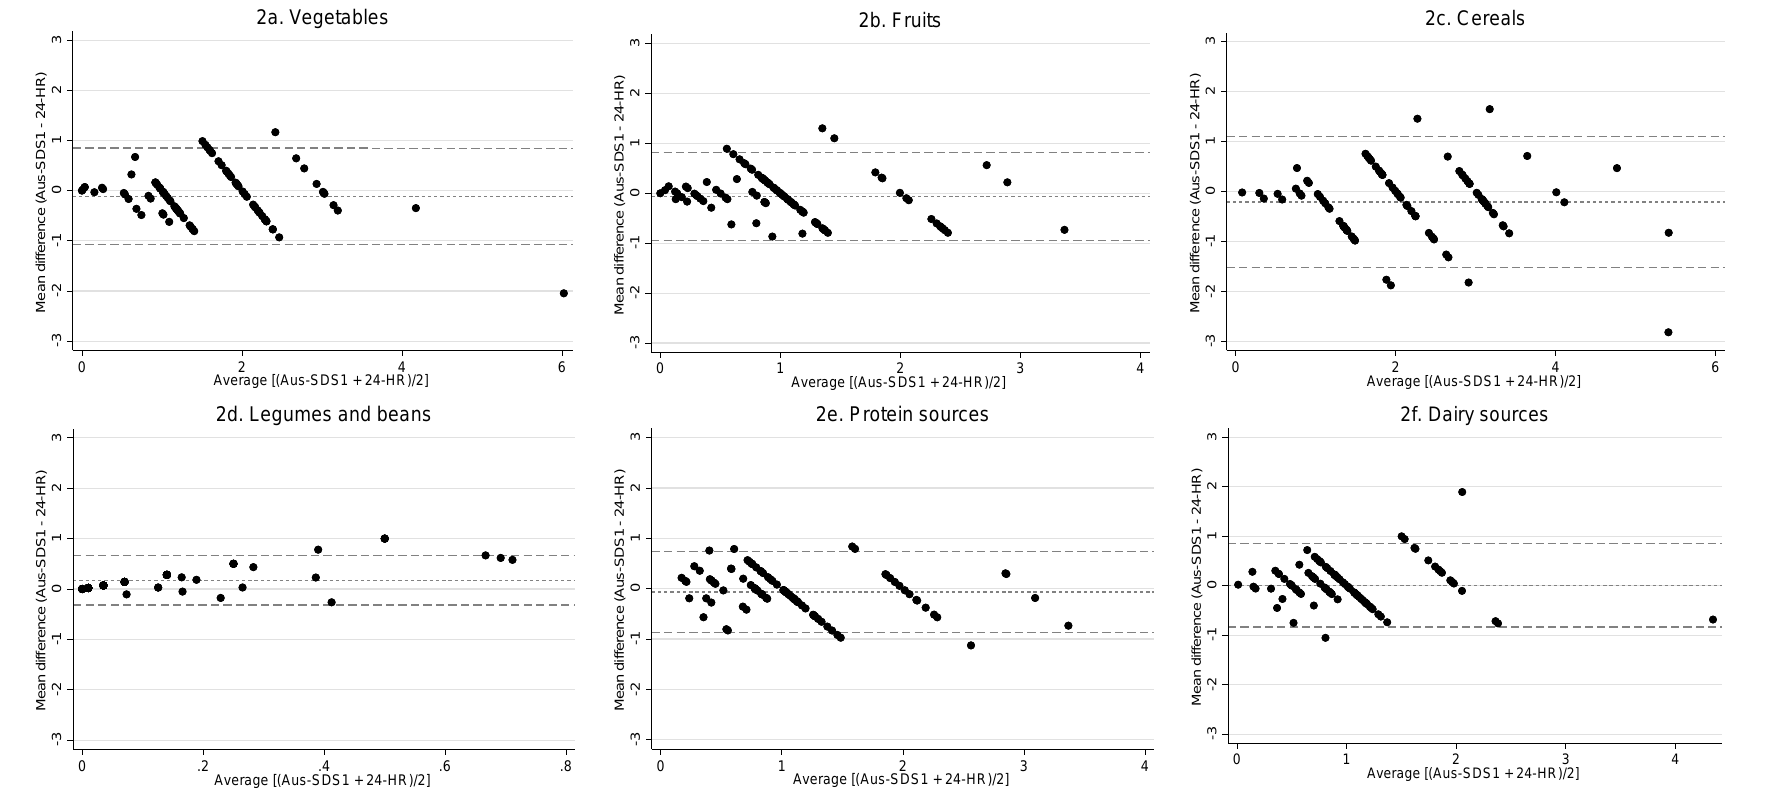
Figure 2. Bland–Altman plot showing the agreement between core food groups (vegetables, fruits, legumes and beans, cereals, protein sources and dairy sources) (serves/day) derived from the Australian Short Dietary Screener (Aus-SDS), and 24-hour recalls (24-HR). Mean difference (bias) is represented by the dotted line, the upper and lower limits of agreement (LOA) by the longer broken lines.